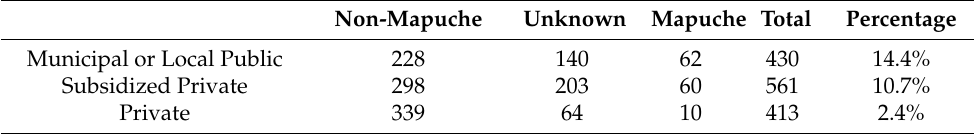
Table 2. Distribution of ancestry based on school type. Source: prepared by the